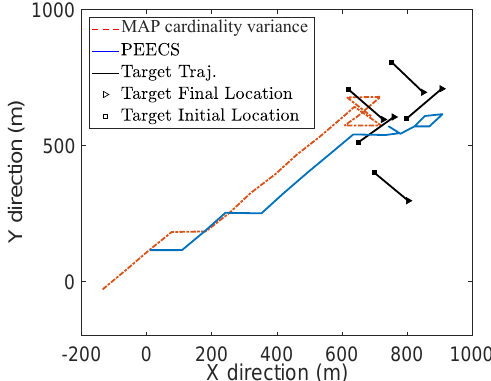
Figure 8. Sensor locations for PEECS [26] and Cardinality variance [32] cost functions (as reported in [26]).